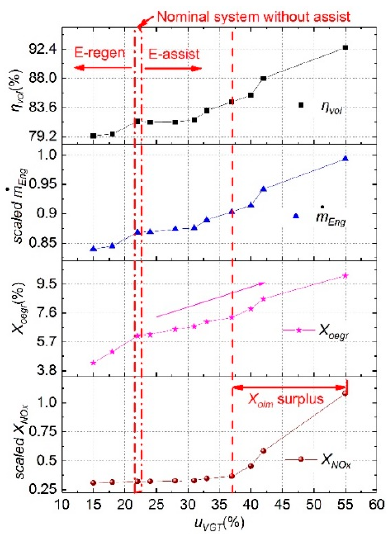
Figure 6. Volumetric efficiency improvement and in-cylinder composition change.